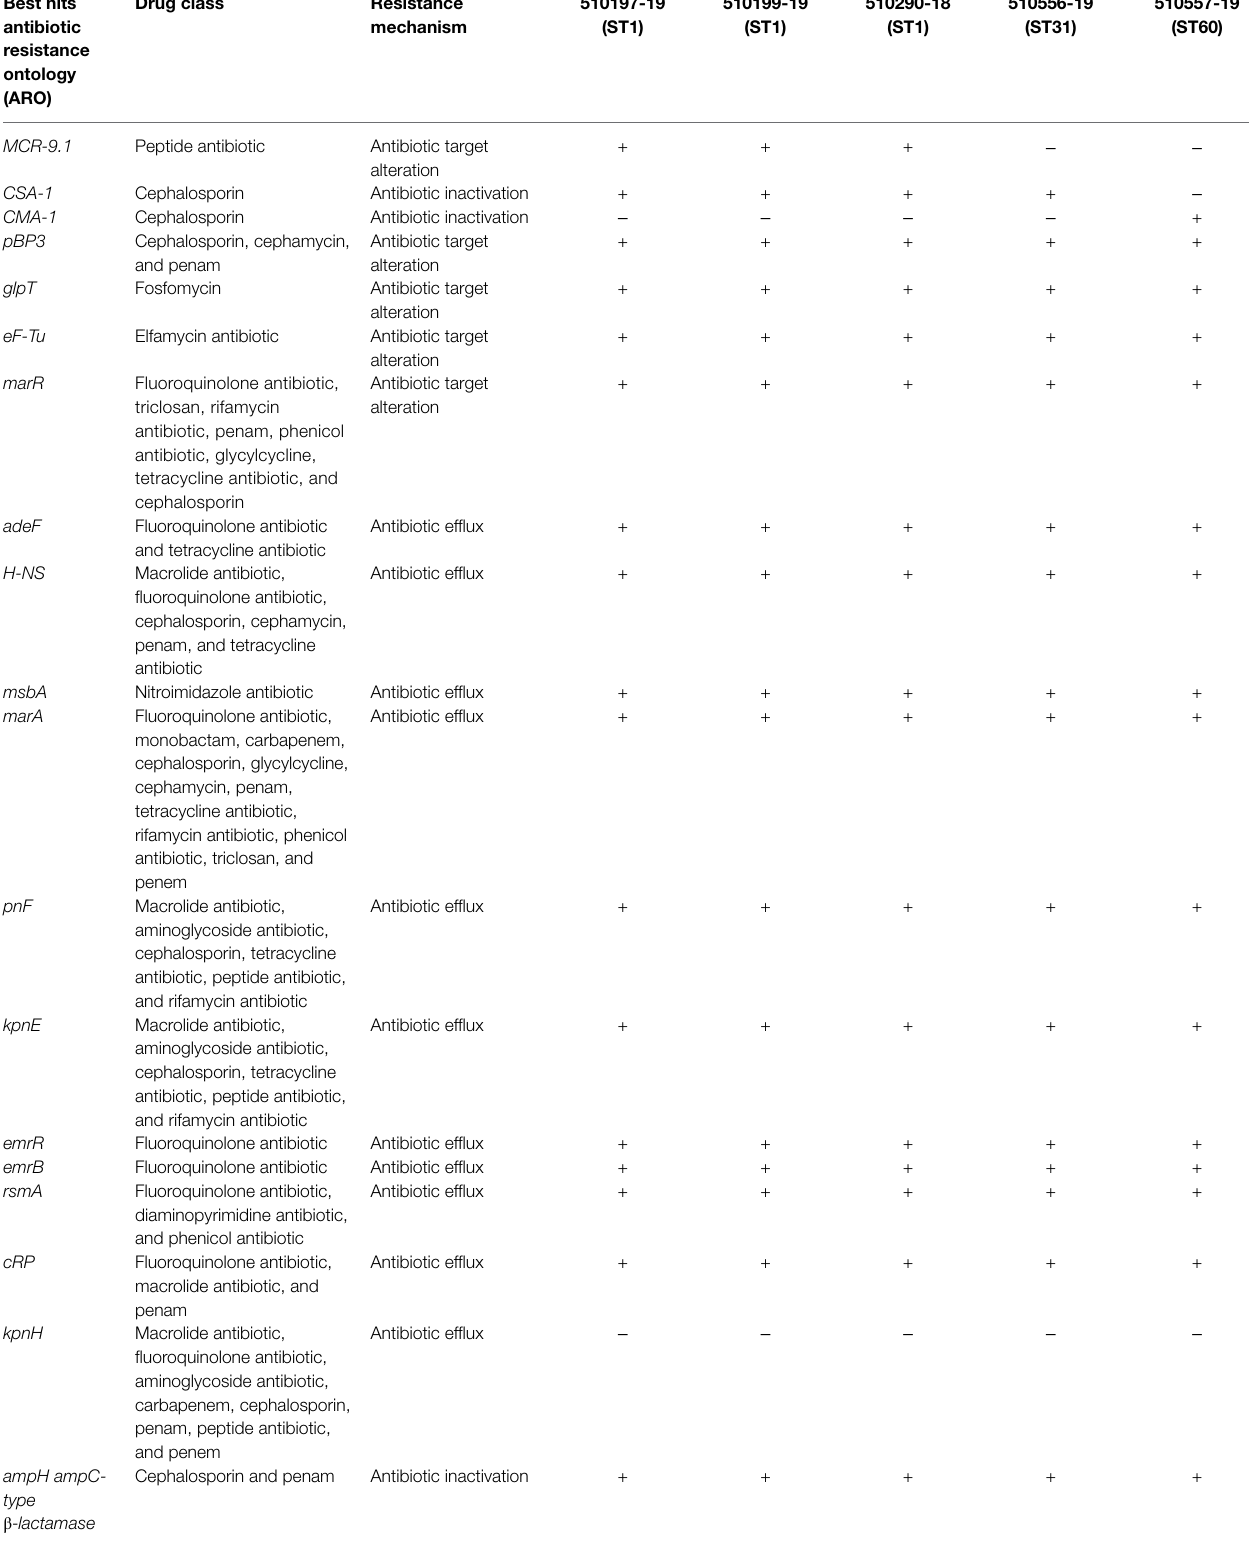
TABLE 3 | Antibiotic-resistant genes of Cronobacter spp. strains identified by Comprehensive Antibiotic Resistance Database (CARD). Best hits antibiotic resistance